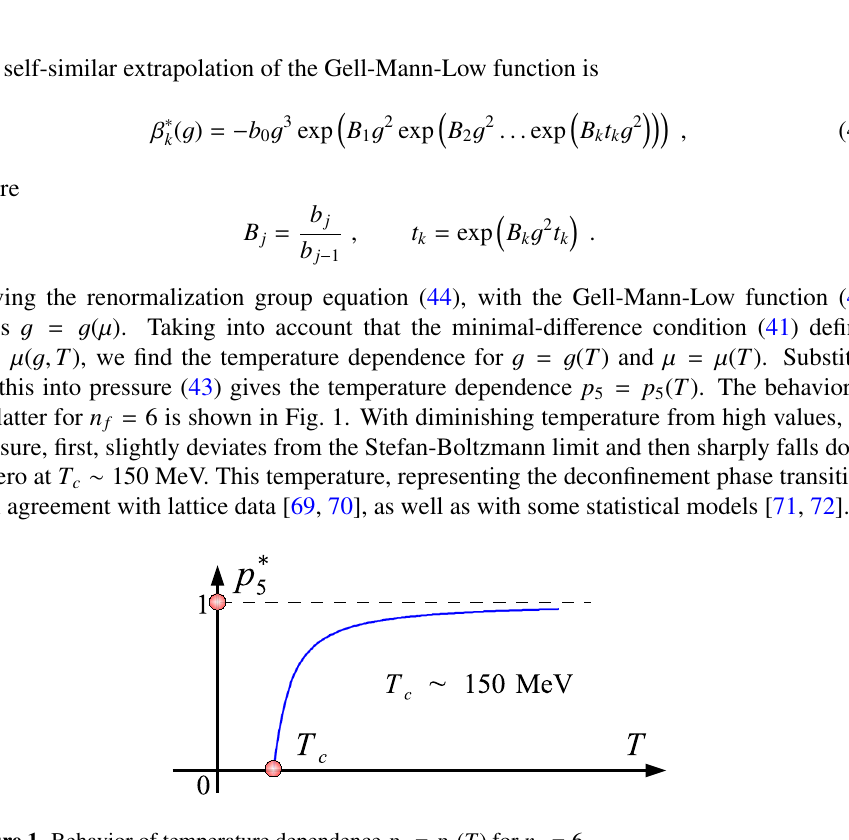
Figure 1. Behavior of temperature dependence p 5 = p 5 ( T ) for n f =